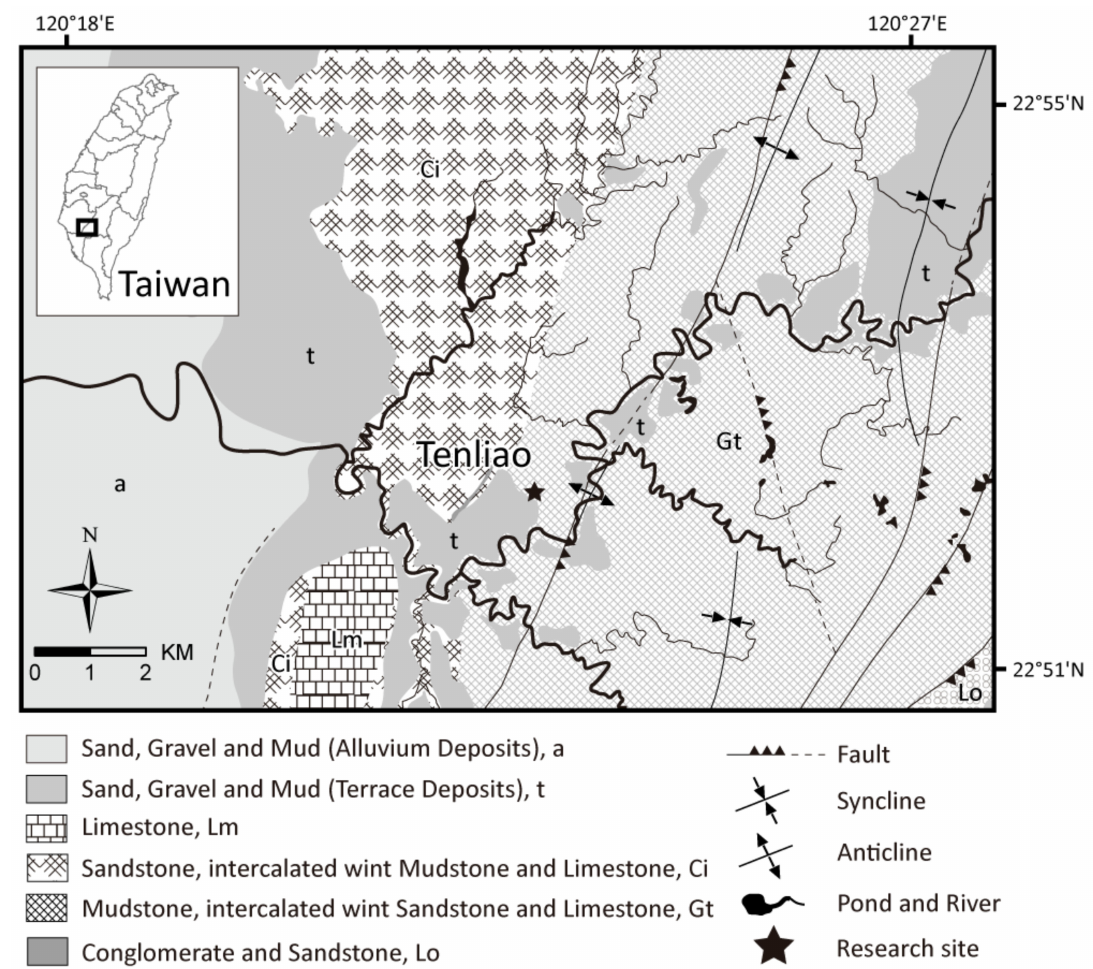
Figure 1. Location of the study area and geological boundary. The star sign shows the study area located in the Gutinkan formation, which shows it as layer t.